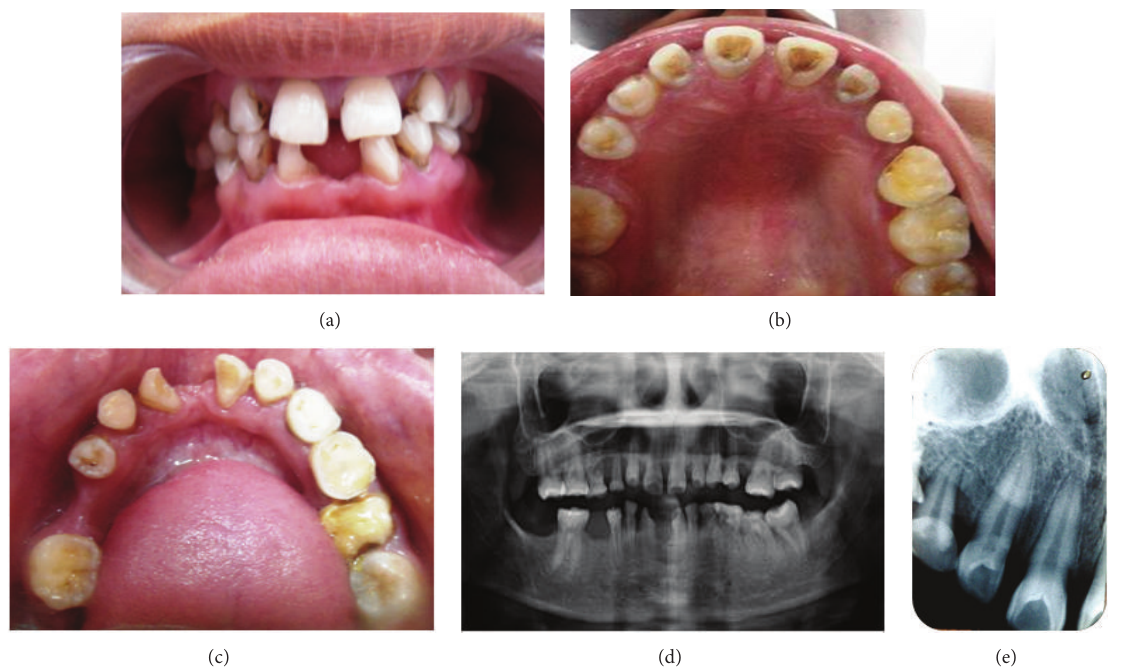
Figure 2: (a) Intraoral photograph of Sibling 2. (b)Intraoral photograph of maxillary arch of Sibling 2. (c)Intraoral photograph of mandibular arch of Sibling 2. (d) OPG of Sibling 2. (e) IOPA of Sibling 2 showing shovel-shaped incisors with dens